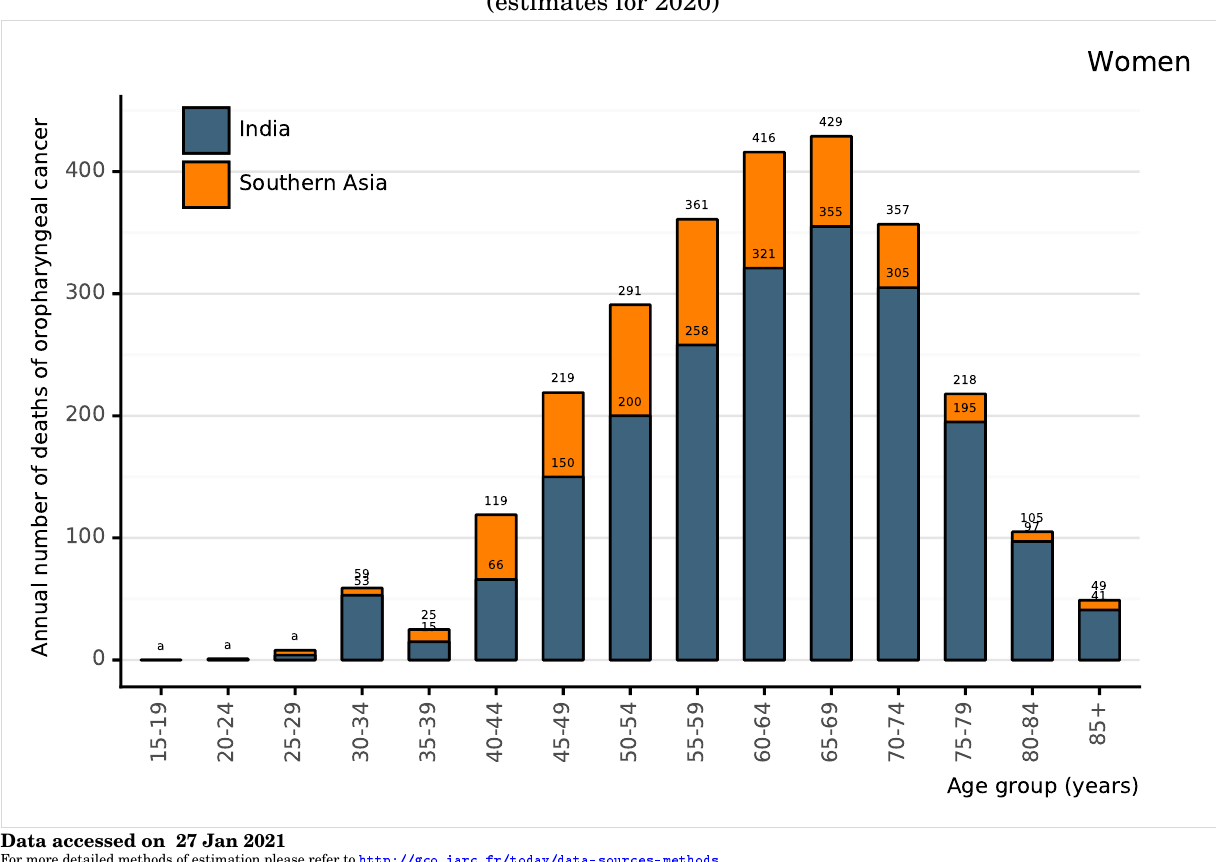
Figure 124: Annual number of deaths of oropharyngeal cancer among women by age group in